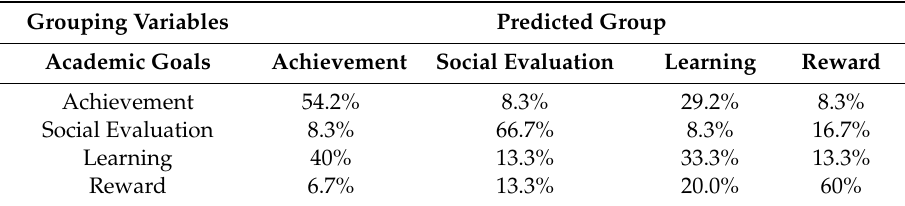
Table 5. Results of the classification using the discriminant function Grouping